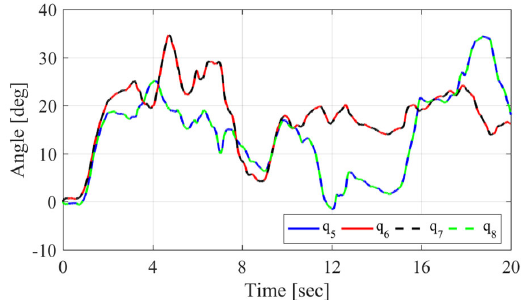
Figure 16. Inverse kinematic solution of distal coupled joint angles with the constraint algorithm using the null space solution.